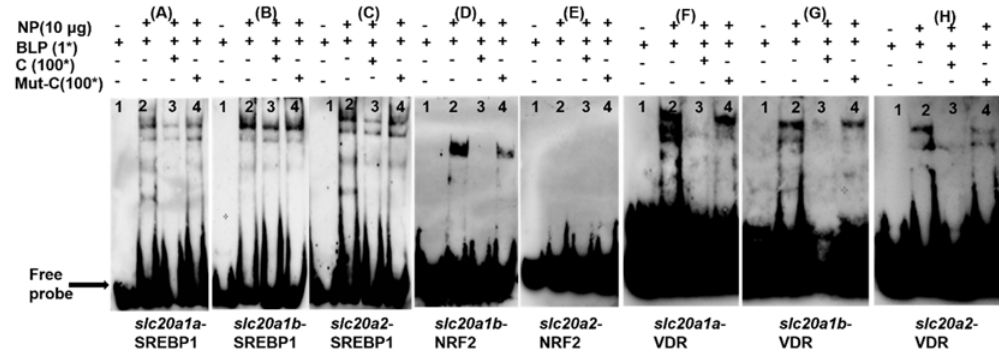
Figure 4. EMSA of putative transcription factors binding sequence. The 5 ′‐ biotin labeled double ‐ stranded oligomers were incubated with HEK293T nuclear extract. A 100 ‐ fold excess of the competitor and mutative competitor oligomers was added to the competition and mutant competition assay, respectively. NP represents nuclear protein; BLP represents biotin ‐ labeled ‐ probe; C represents competitor oligomers; Mut ‐ C represents mutative competitor oligomers. The oligonucleotide sequences are given in Table S4. ( A ) SREBP1 binding sequences located at − 783/ − 771 bp of the slc20a1a promoter. ( B ) SREBP1 binding sequences located at − 1187/ − 1178 bp of the slc20a1b promoter. ( C ) SREBP1 binding sequences located at − 987/ − 977 bp of the slc20a2 promoter. ( D ) NRF2 binding sequences located at − 572/ − 561 bp of the slc20a1b promoter. ( E ) NRF2 binding sequences located at − 1469/ − 1459 bp of slc20a2 promoter. ( F ) VDR binding sequences located at 260/ − 253 bp of the slc20a1a promoter. ( G ) VDR binding sequences located at − 615/ − 609 bp of the slc20a1b promoter. ( H ) VDR binding sequences located at − 1124/ − 1117 bp of the slc20a2 promoter.